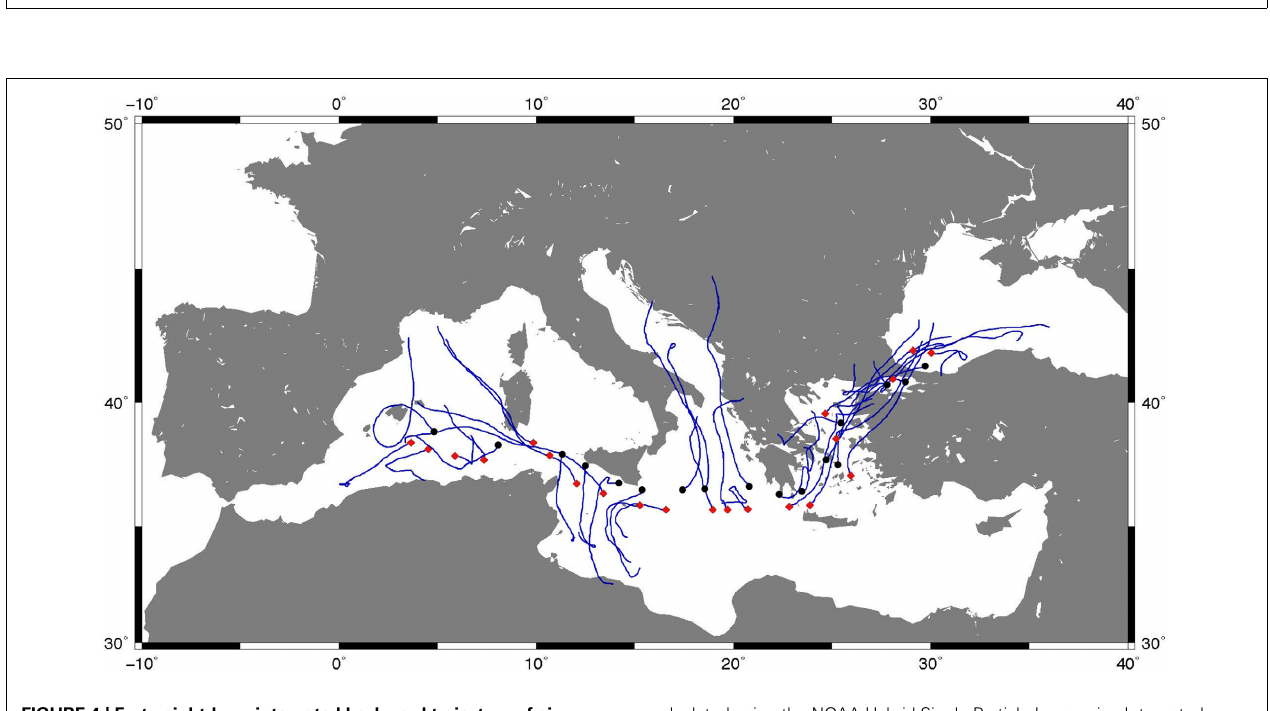
calculated using the NOAA Hybrid Single-Particle Lagrangian Integrated Trajectory Model (HYSPLIT) available at http://ready.arl.noaa.gov/HYSPLIT_